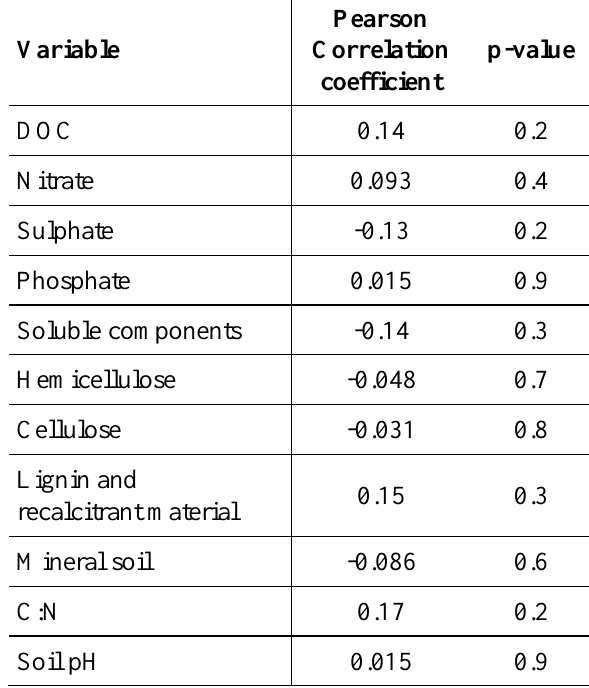
) fluxes with 4 Table 6. Correlations of methane (CH biochemical parameters across the deep cores flux. 4